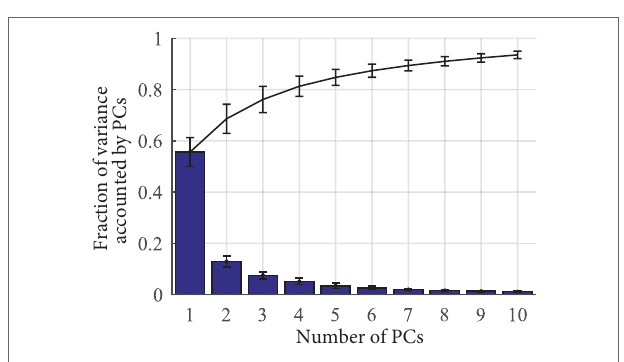
FigUre 3 | Bars show the mean fraction of variance accounted by each principle component (Pc) across subjects . Error bars indicate SD. The line plot shows how these variances accumulate from the first PC to the last